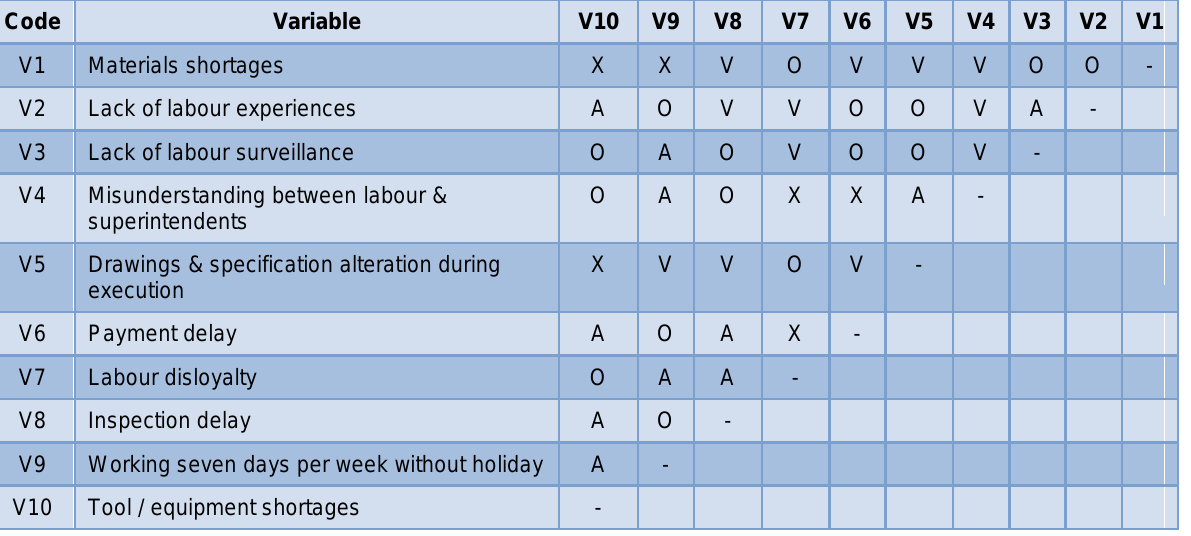
Table 1 Structural self interaction matrix